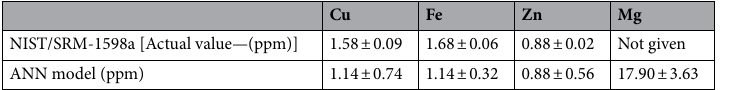
Table 1. Comparison of Cu, Fe, Zn, Mg by ANN and SRM-1598a concentration 57